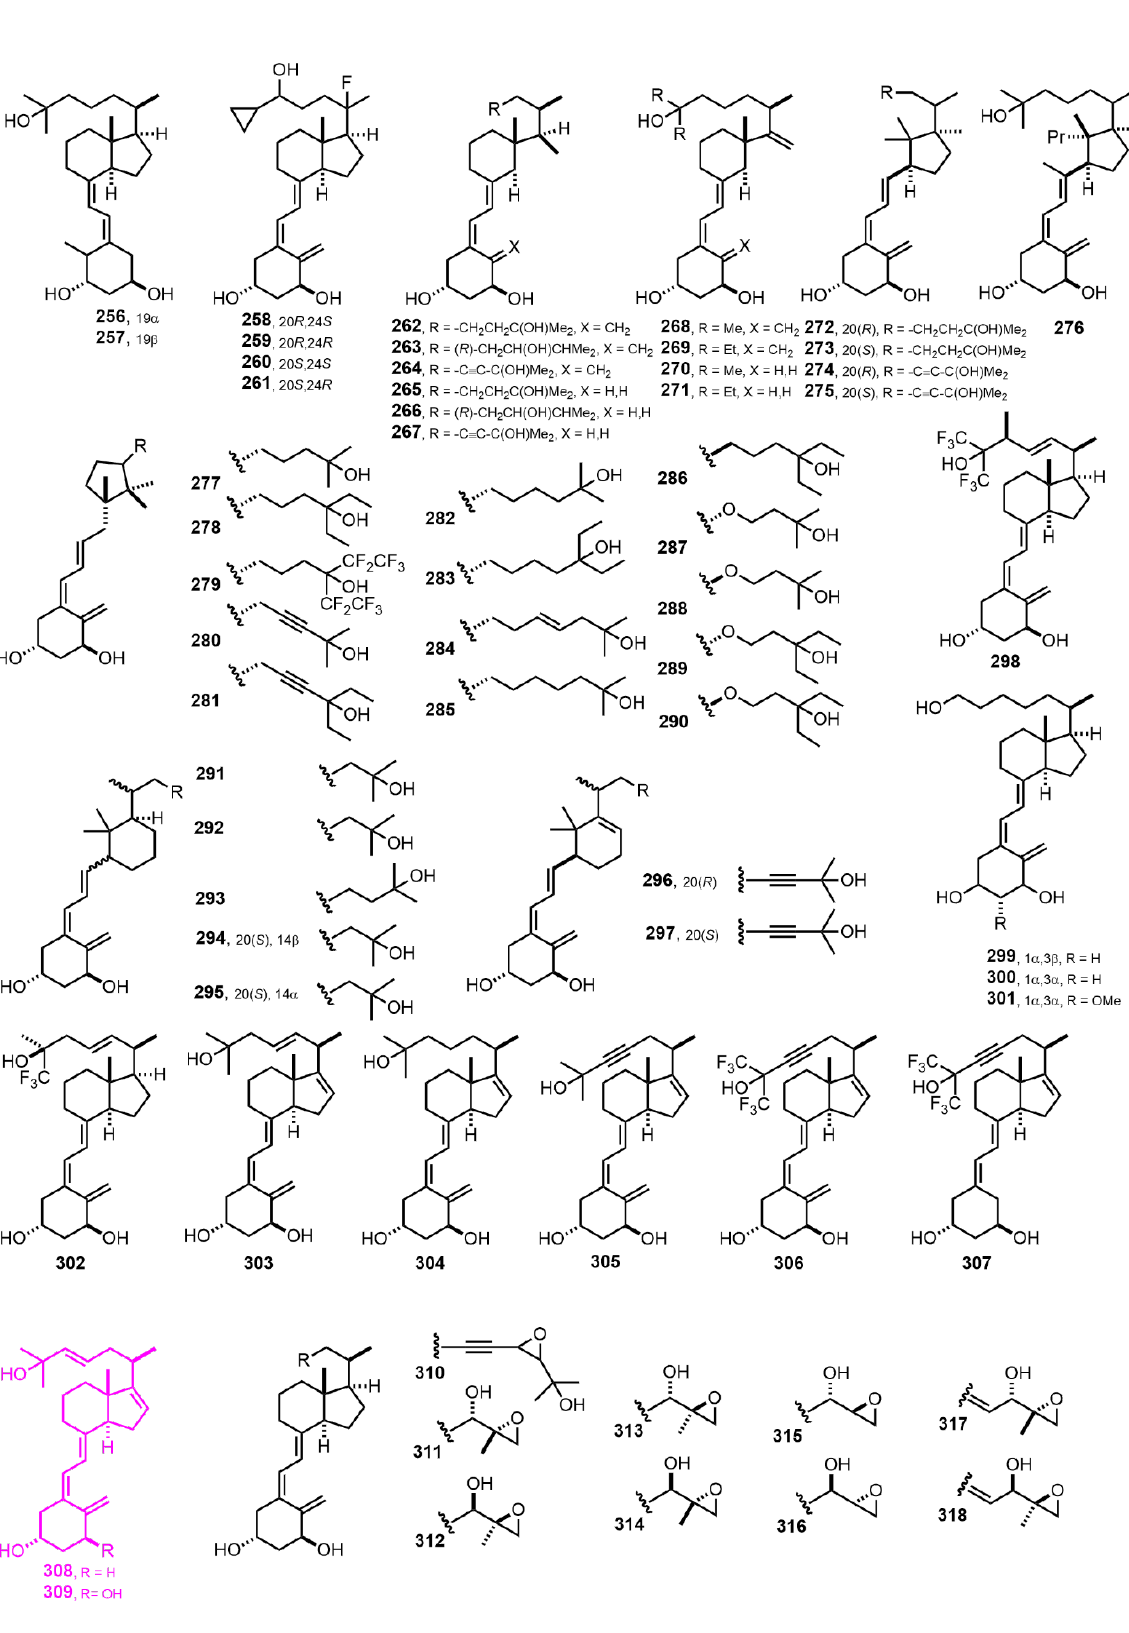
Figure 7. (1994-1997) [136 – 148].